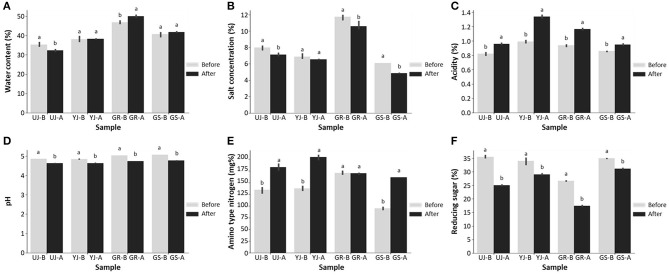
Differences before and after fermentation of (A) water content, (B) salt concentration, (C) acidity, (D) pH value, (E) amino-type nitrogen, and (F) reducing sugar of gochujang produced in four regions. Data values are indicated as the mean ± standard deviation. Values followed by different letters in the same sample are significantly different (p < 0.05).